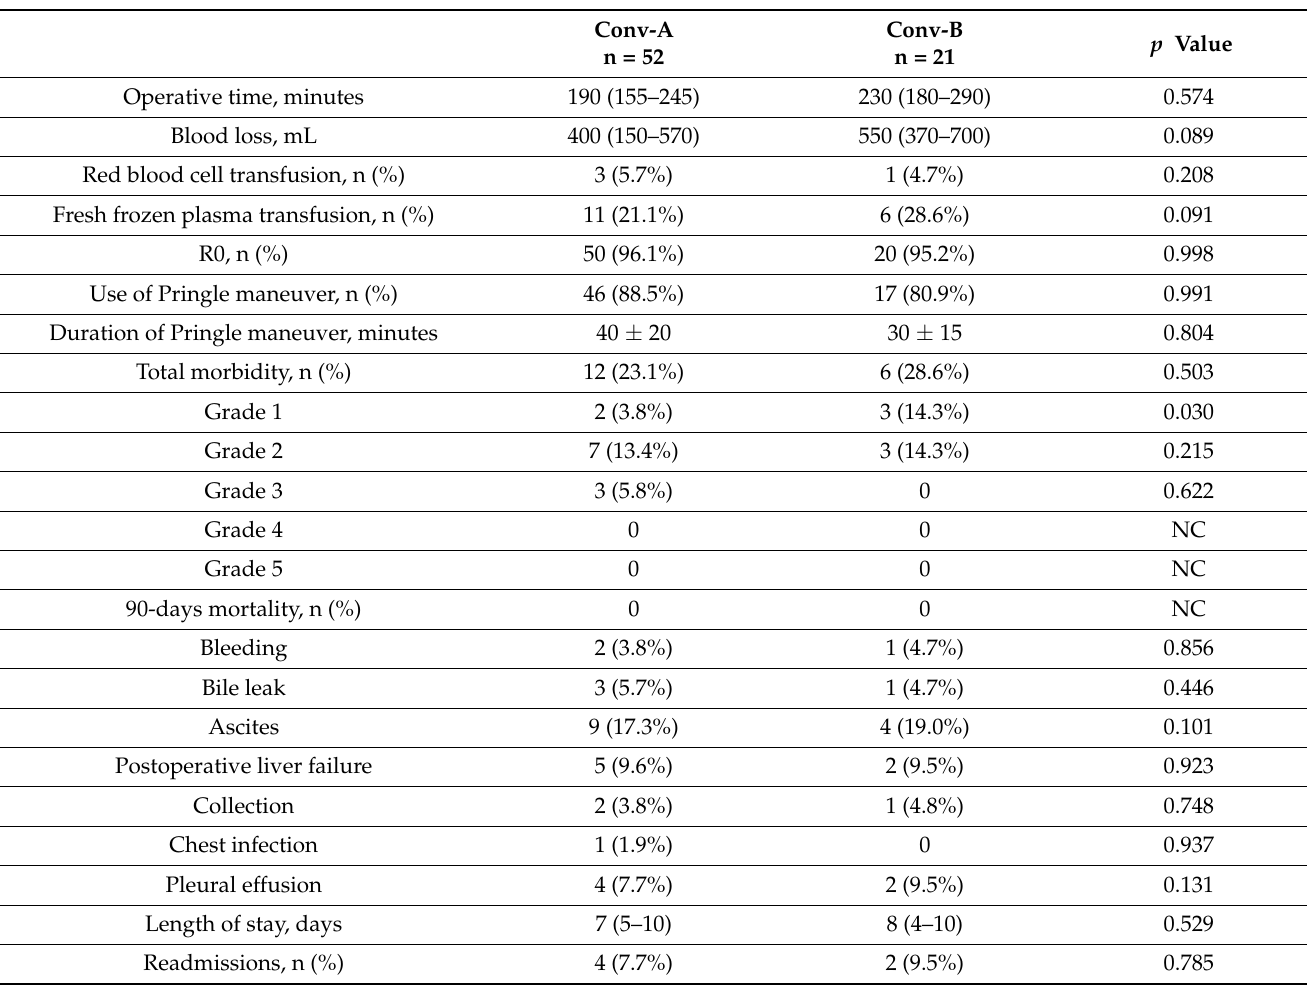
Table 5. Results of converted MILRs for HCC: Child A versus converted MILRs in advanced cirrhosis (Child B and Child A/B with portal hypertension)